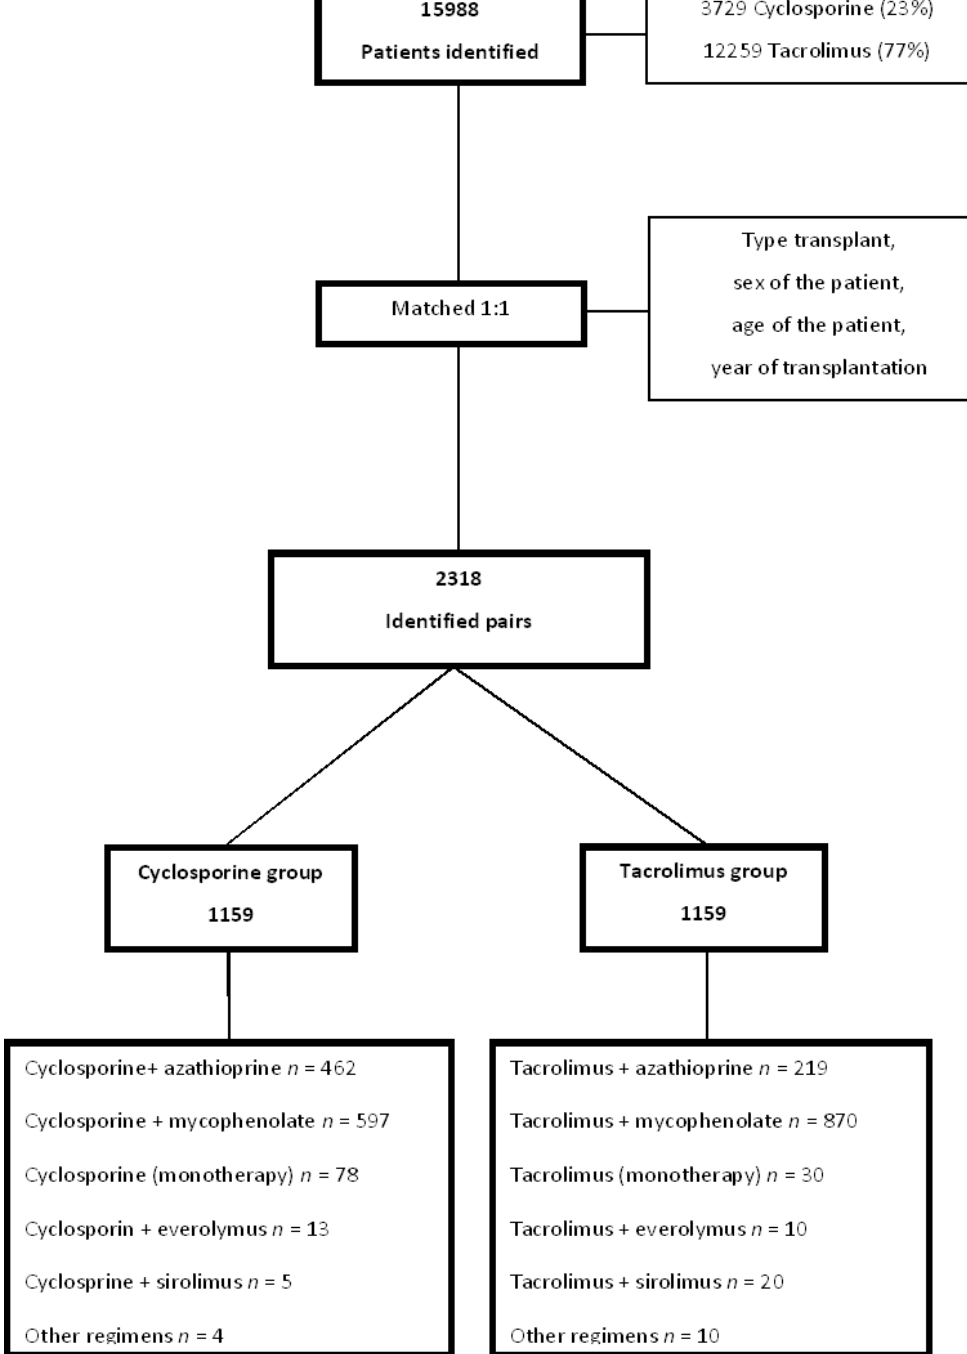
Figure 1. Study flowchart (Brazil, 2000–2015; n = 2318).